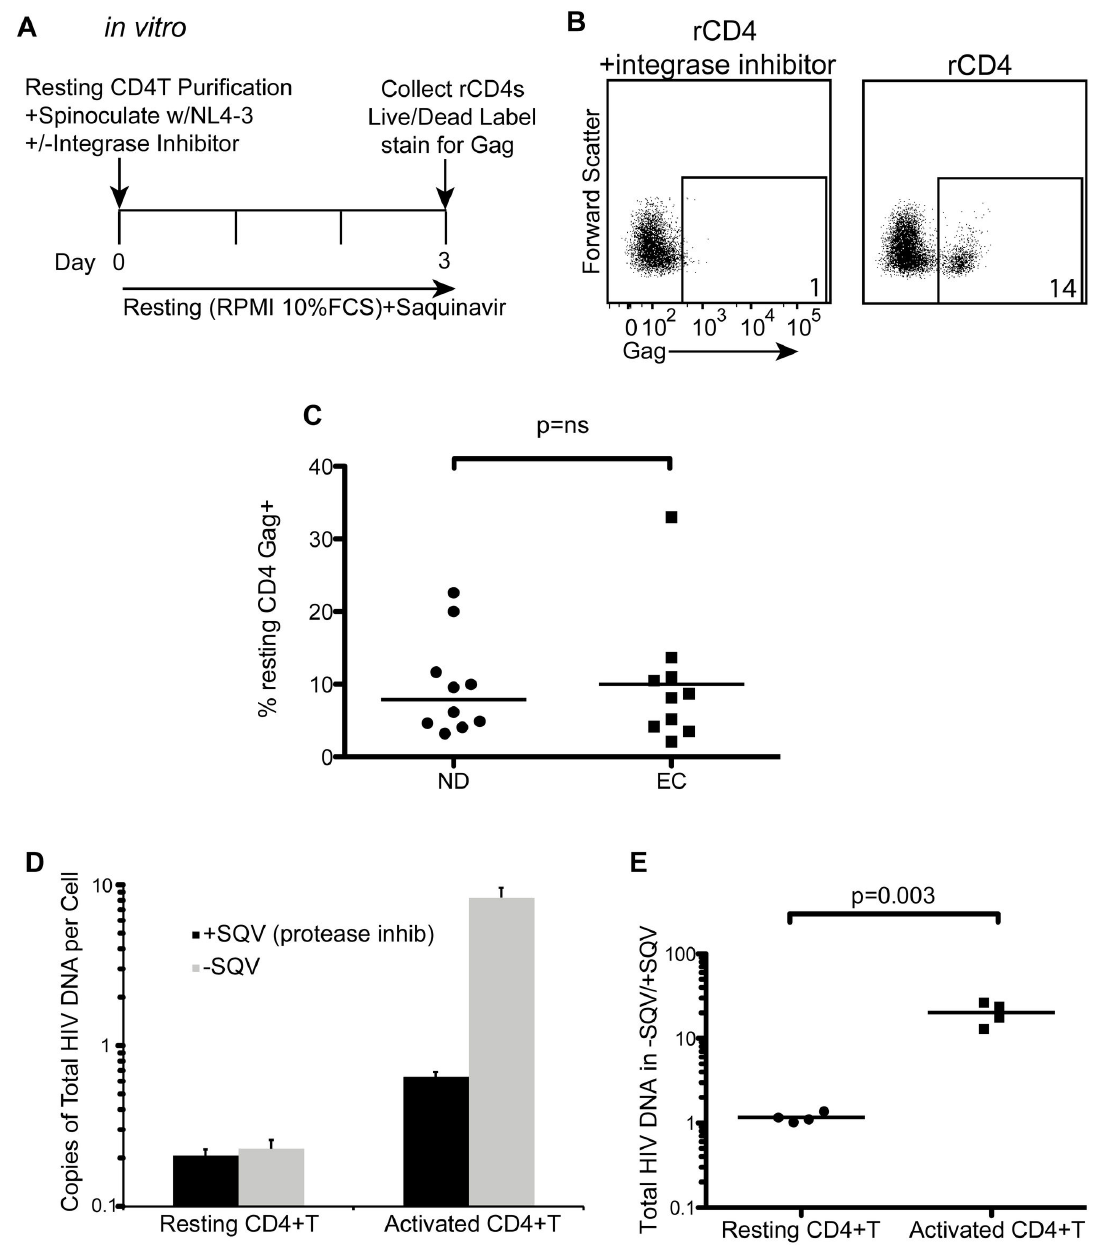
Figure 1. Superinfected resting CD4+ T cells express HIV proteins without producing detectable viral spread. (A) Resting CD4+ T cells were isolated from frozen PBMC by negative bead depletion and spinoculated with HIV-1 days without stimulation in the presence saquinavir (SQV). Resting conditions refer to culture in RPMI+ 10% FCS. After 3 days cells were collected, labeled with a viability dye and activation markers, then fixed and permeabilized and stained for intracellular HIV Gag. (B) Resting CD4+ T cells were gated by excluding HLA-DR, CD25 and CD69 and analyzed for the presence of intracellular Gag with or without addition of Raltegravir at the time of infection, using a reverse-transcriptase inhibitor-treated control also added at the time of infection to set the Gag positive gates. At time 0 and day 3 resting CD4+ T were determined to be 99% negative for activation markers (not shown) but consistent with [24]. (C) The frequency of cells expressing HIV Gag after in vitro infection and 3 day culture was compared among normal donors (ND, n=6) and elite controllers (EC, n=6). (D) Total HIV DNA was measured in superinfected resting or activated cells and compared between +SQV and -SQV fractions from one representative experiment in an EC. (E) Summary data from 4 different EC donors as in D, showing the ratio of total HIV DNA in the -SQV divided by the +SQV fraction. Lines represent the median and p values were generated using the Mann-Whitney test. doi: 10.1371/journal.pone.0071879.g001 PLOS ONE |